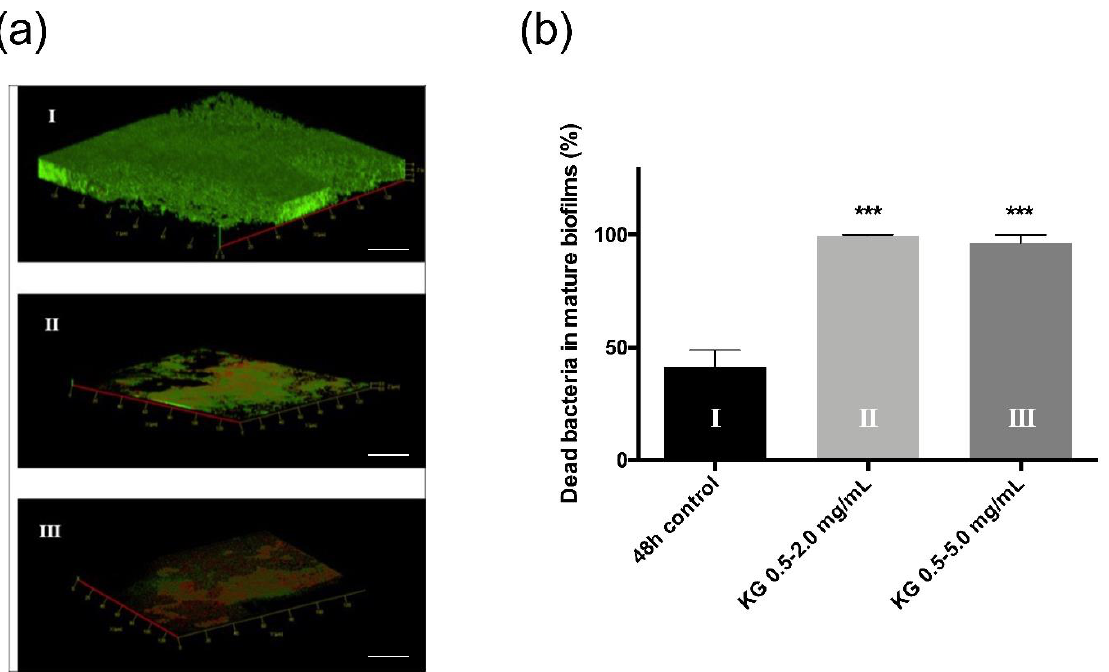
Figure 5. Live/dead staining images of confocal z-stacks (green = all bacteria, red = dead) of dual-species mature biofilms of S. aureus – P. aeruginosa after 24 h without active molecules ( a-I ), or in contact with KG 0.5 – 2.0 mg/mL ( a-II ) or KG 0.5 – 5.0 mg/mL ( a-III ). White bars represent 20 µm. Additionally, quantification of the percentage of dead bacteria ( b ). Statistically significant differences with 48 h control are marked with asterisks: *** p ≤ 0 .001 .